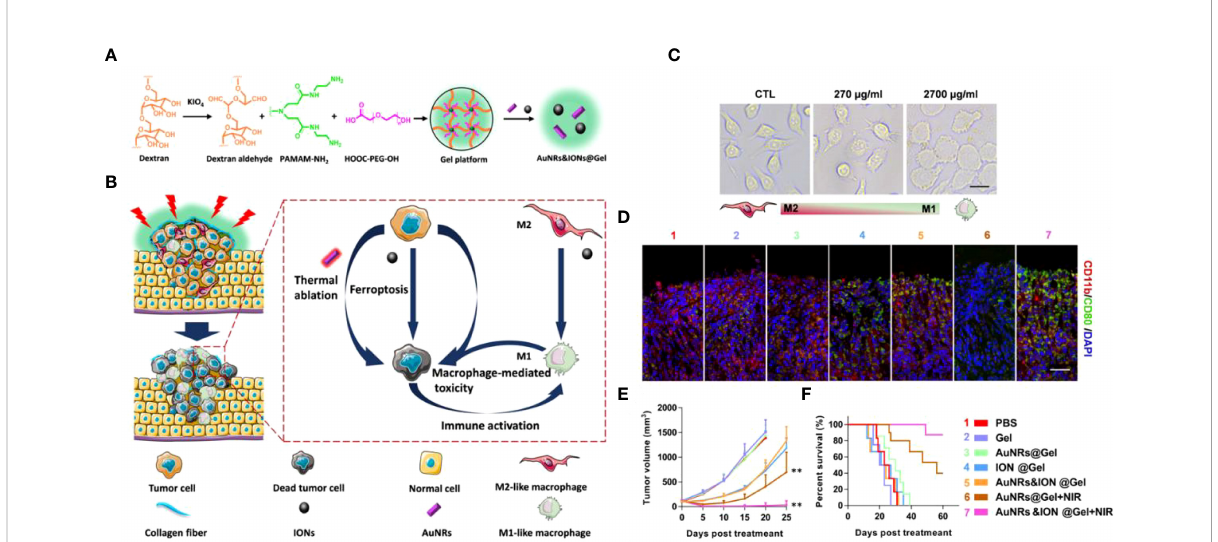
FIGURE 8 (A) . Schematic diagram of AuNRs & IONs@Gel synthesis. (B) Schematic diagram of AuNRs & IONs@Gel induced tumor cell death that can be used for PTT, ferroptosis, and immunotherapy. (C) Morphological images of M2-type macrophages after co-incubation with IONs (Scale Bar = 10 m m). (D) Immuno fl uorescence staining of tumor sections from mice receiving different treatments, CD11b (red) and CD80 (green) (Scale Bar = 10 m m). (E) Tumor size of receiving different treatment modes after 25 days (n = 5). (F) Survival curves of mice treated with different regimens (n = 10). Treatment groups: 1, PBS; 2, Gel; 3, AuNRs@Gel; 4, IONs@Gel; 5, AuNRs & IONs@Gel; 6, AuNRs@Gel + NIR; 7, AuNRs & IONs@Gel + NIR (**p < 0.01) (136). Reprinted with permission from Ref. (136). Copyright© 2020, copyright Guo et